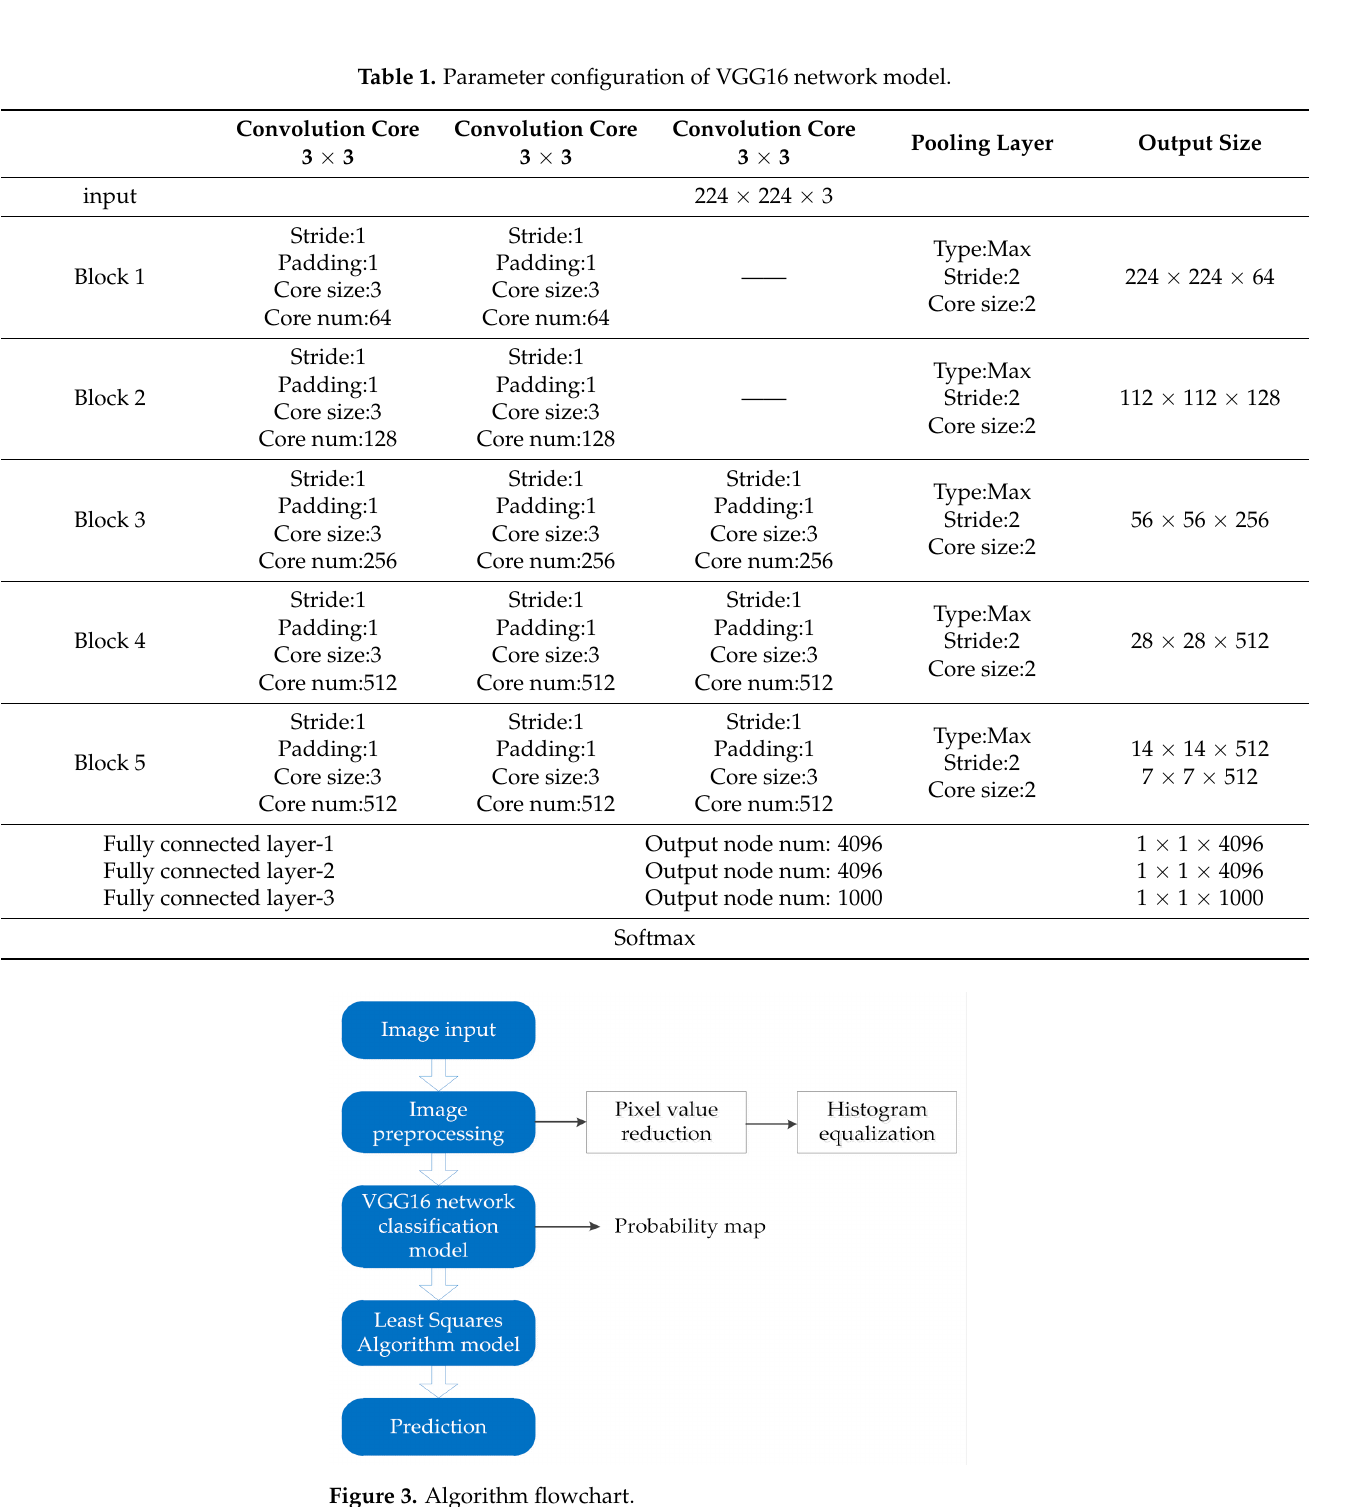
Figure 3. Algorithm